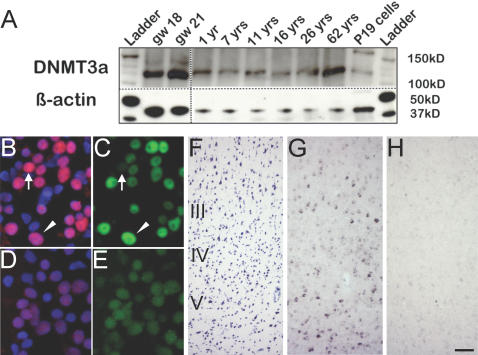
Developmental and cellular expression pattern of DNMT3a in the cerebral cortex.(A) Representative immunoblotting of temporal cortex homogenates with anti-DNMT3a antibody (top) and β-actin as loading control (bottom). Left, fetal samples (gw = gestational week); right, child and adult brains (yrs = years) and, as positive control, murine embryonic carcinoma, “P19” cells. Notice expression of DNMT3a—indicated by a ∼120 kDa band—across all ages. (B, C) Digitized images of temporal cortex nuclei from 1 year old infant, processed for DNMT3a (red) and NeuN (green) immunoreactivity and counterstained with DAPI. Notice numerous neuronal nuclei expressing both markers, including representative example marked by arrowhead. Occasional non-neuronal DNMT3a+ nucleus is marked by arrow. (D,E) show weak background staining and formalin fixation-related autofluorescence in negative controls processed without primary antibodies. (F–H) Images from layers III, IV and V of parallel sections from adult temporal cortex, stained for Nissl (F) or hybridized with digoxigenin-labeled DNMT3a antisense (G) or sense riboprobe (H). Notice in (G) robust expression of DNMT3a mRNA in a subset of layer III and V neurons. Images in B–E taken at with 20× objective. Bar (F–H) in H = 100 µm.